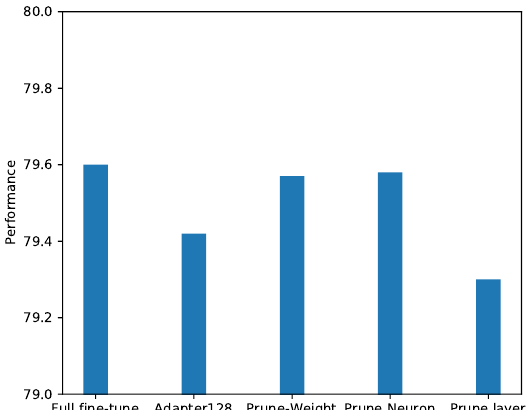
Figure 2. Comparisons of average performance of different models on GLUE test sets.